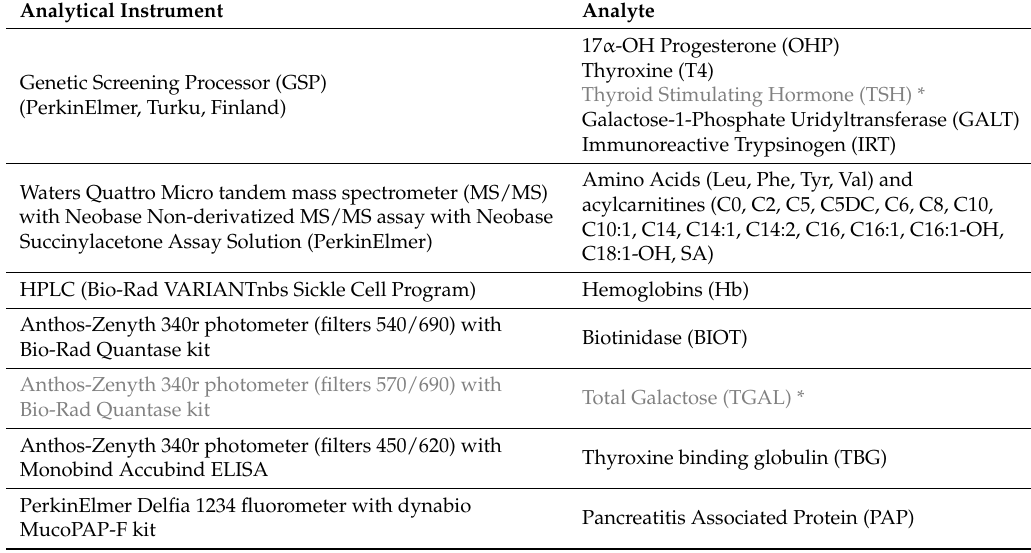
Table 1. Analytical methods employed and analytes measured within the Dutch Newborn Screening (NBS) programme, and for which the effect of glue was evaluated (RIVM: reference laboratory for neonatal screening).